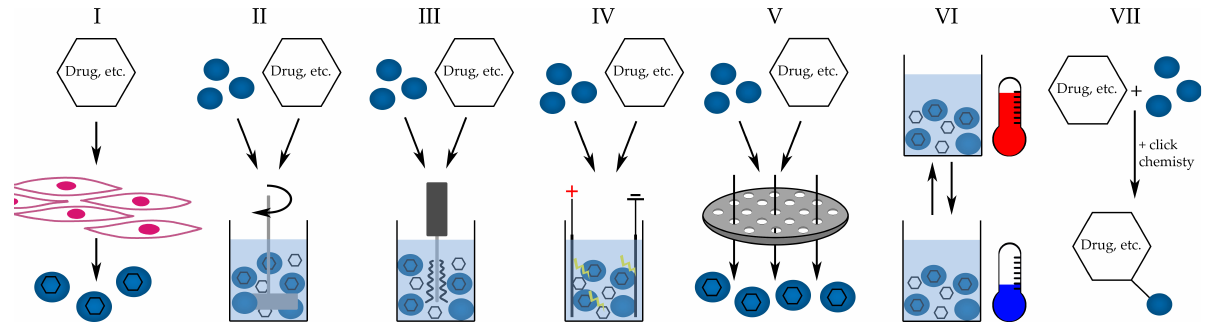
Figure 3. Methods of loading drugs into exosomes. ( I )—drug loaded exosomes released from drug exposed cells, ( II )—drug incubation with exosomes with additional stirring, ( III )—sonication, ( IV )—electroporation, ( V )—extrusion, ( VI )—freeze-thaw cycles, ( VII )—chemical conjugation of drug to